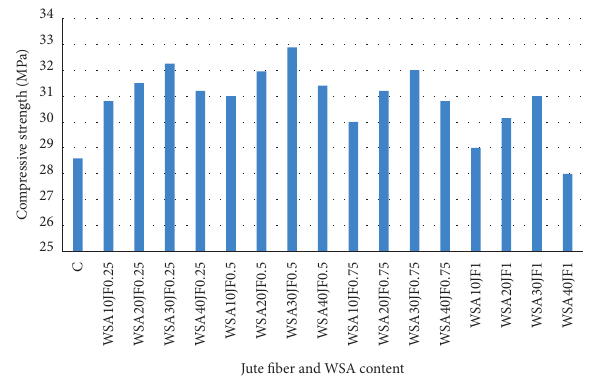
Figure 5: Compressive strength of mxture containing jute fiber and WSA.